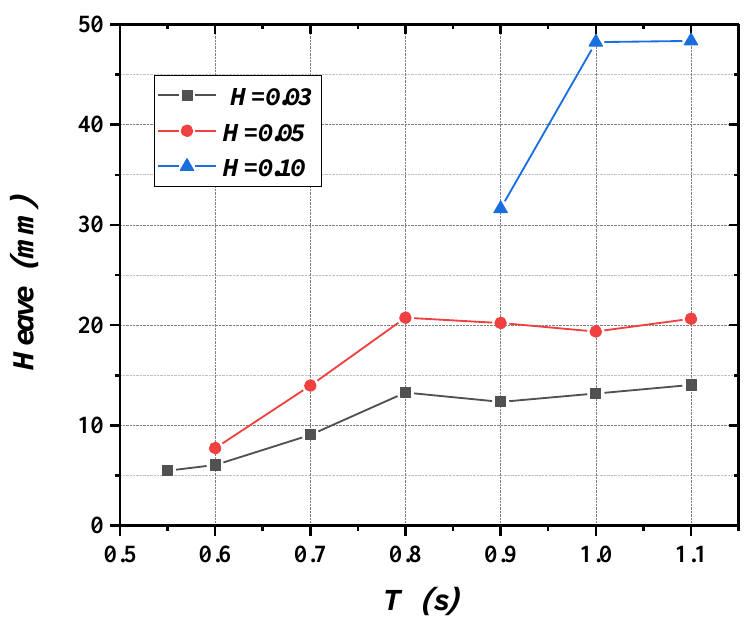
Figure 26. Variations of heave with period and wave height.